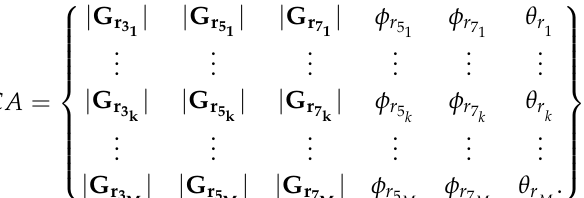
, with N S = { 3,5,7 } , for a pixel from a RGB Si